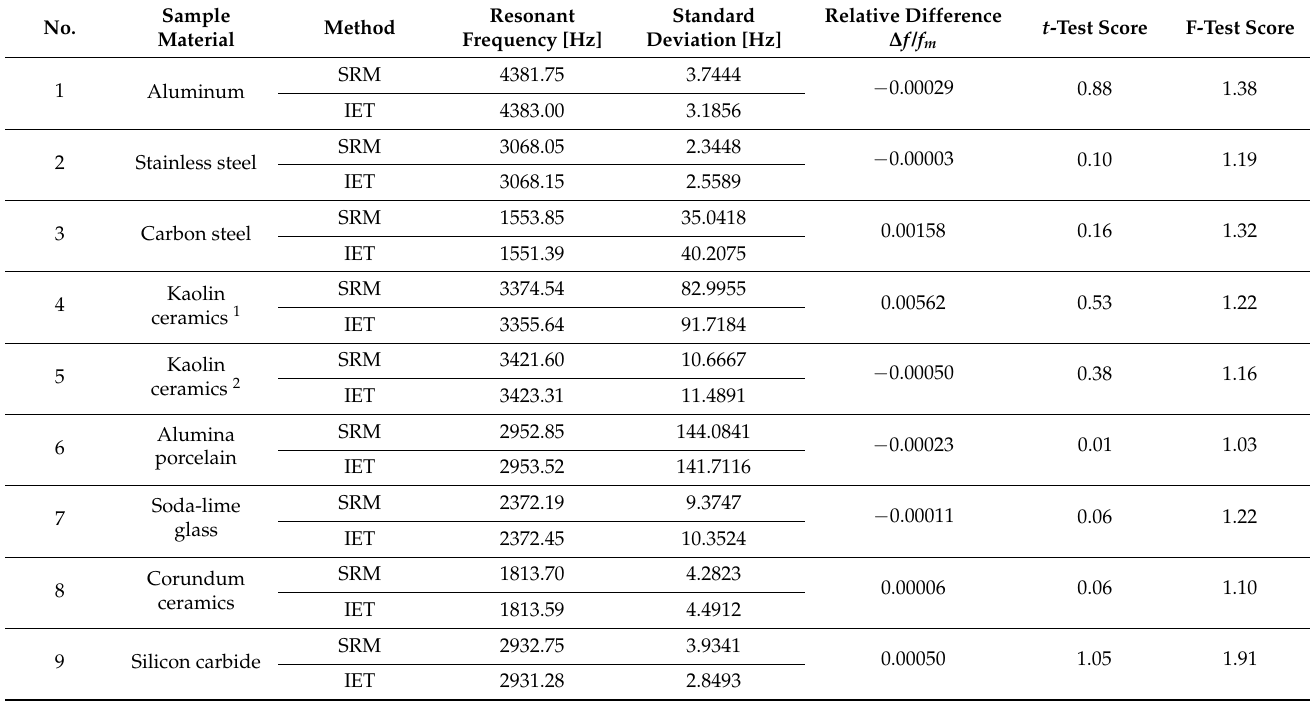
Table 2. Resonant frequency measured using SRM and IET